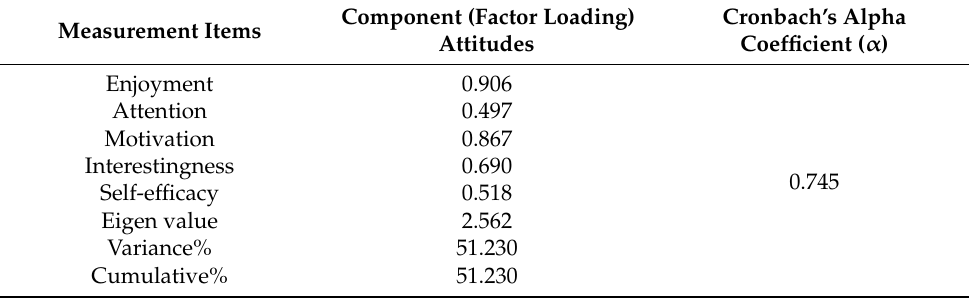
Table 3. Reliability and validity of the 5-item attitudinal questionnaire.